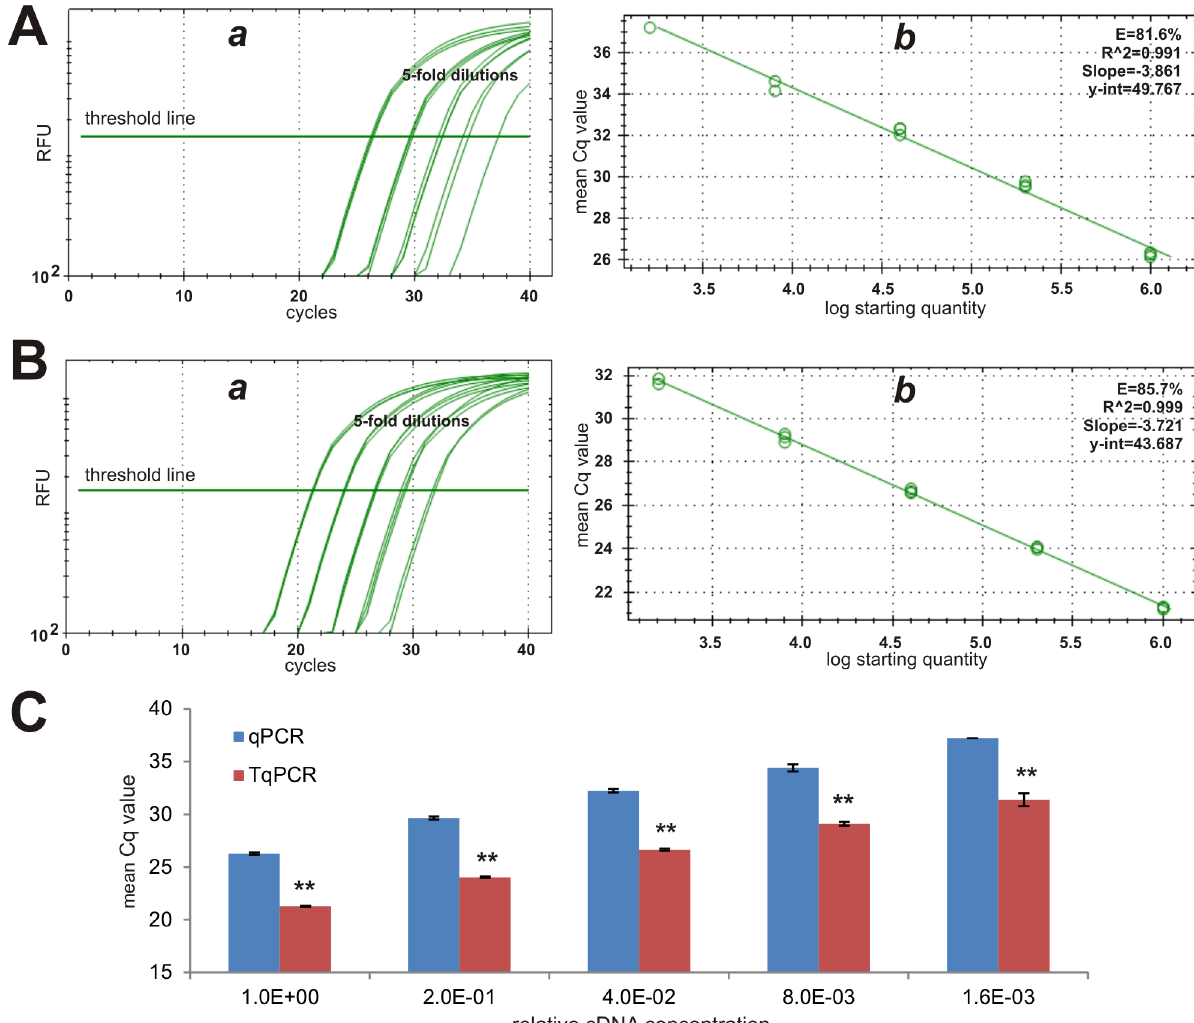
Fig 3. Comparative analysis of moderately abundant reference gene Rps13 expression detected by conventional qPCR and TqPCR. The cDNA sample was prepared from the exponentially growing iMEF cells and was 5-fold serially diluted for PCR amplification, as described in Fig 2. Primers specific for mouse Rps13 were used to detect its expression with the conventional qPCR (A) and TqPCR (B) protocols using CFX-Connect qPCR unit (Bio-Rad). The qPCR SYBR Green fluorescence history vs. cycle numbers ( a ) and the qPCR efficiencies of Rps13 ( b ) were analyzed and presented. The mean Cq value comparison of the two procedures was further graphed (C) . “ ** ” , indicating the Cq difference between qPCR and TqPCR groups is significant with p <